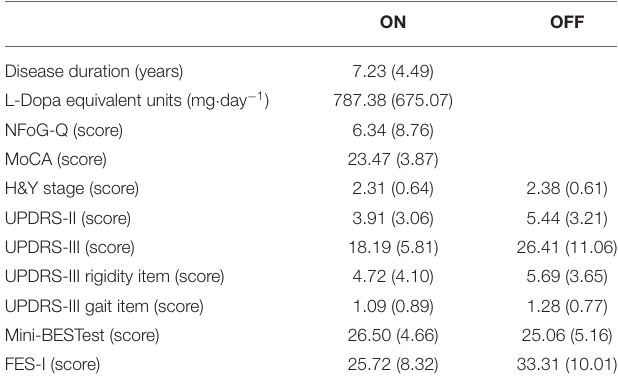
TABLE 1 | Mean (standard deviation) of the characteristics of the participants separately by medication condition.